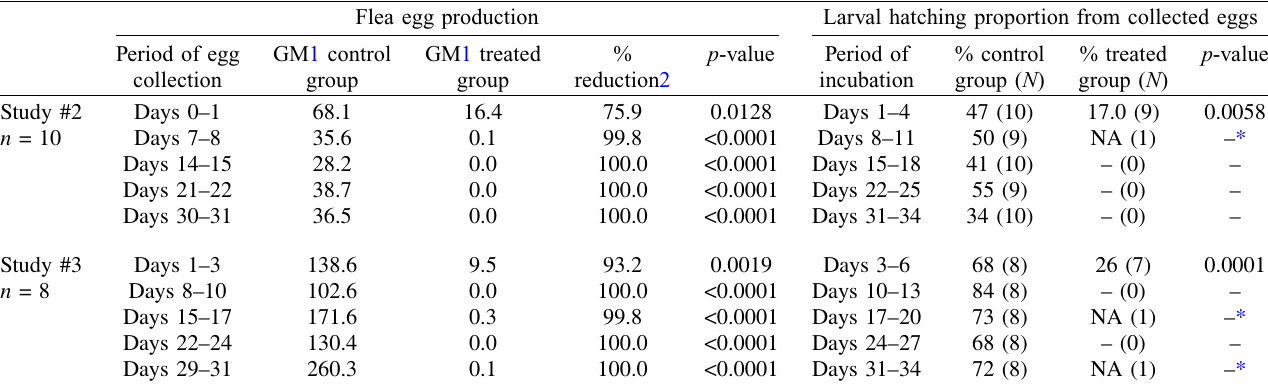
Table 5. Ctenocephalides felis egg production reduction and larval hatching inhibition. Flea egg production Larval hatching proportion from collected